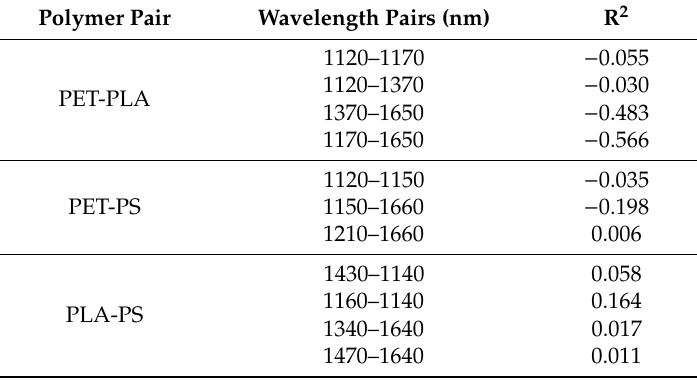
Table 3. Wavelength pairs corresponding to the minimum values of the correlation matrices for each couple of